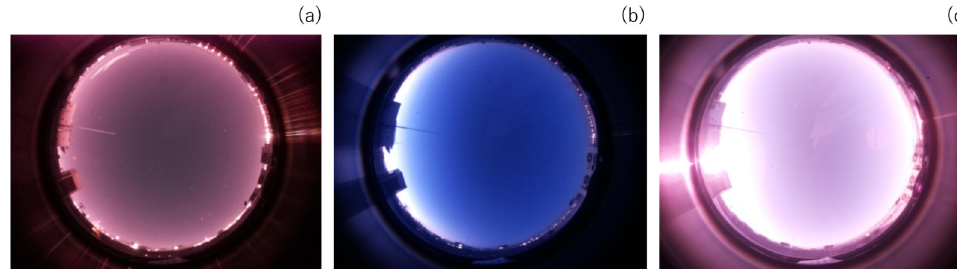
Figure 5. All-sky camera images at CHF around the time of EQ1: ( a ) 1.5 h before the EQ, ( b ) 30 min before the EQ, and ( c ) 30 min after the EQ.